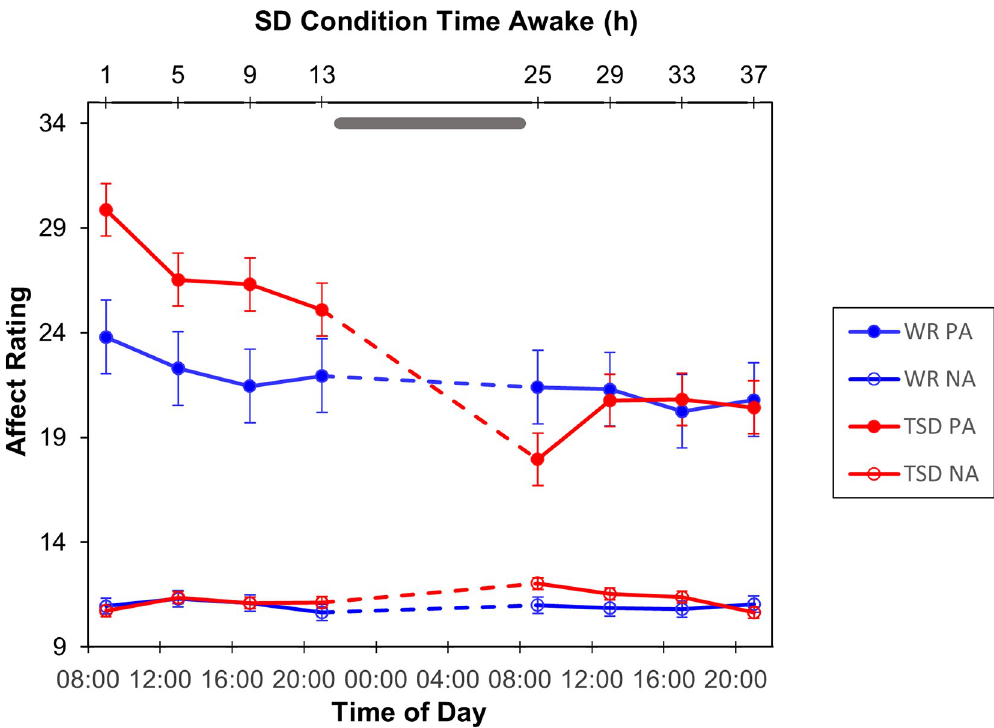
Fig 2. Positive affect (PA) and negative affect (NA) ratings on the PANAS (mean ± SE) for subjects in the TSD (red) and WR (blue) conditions. Grey bar represents sleep opportunity for WR condition and time awake for TSD